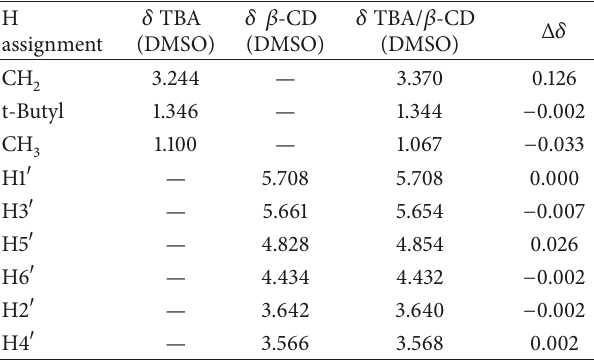
CD complex (see Scheme